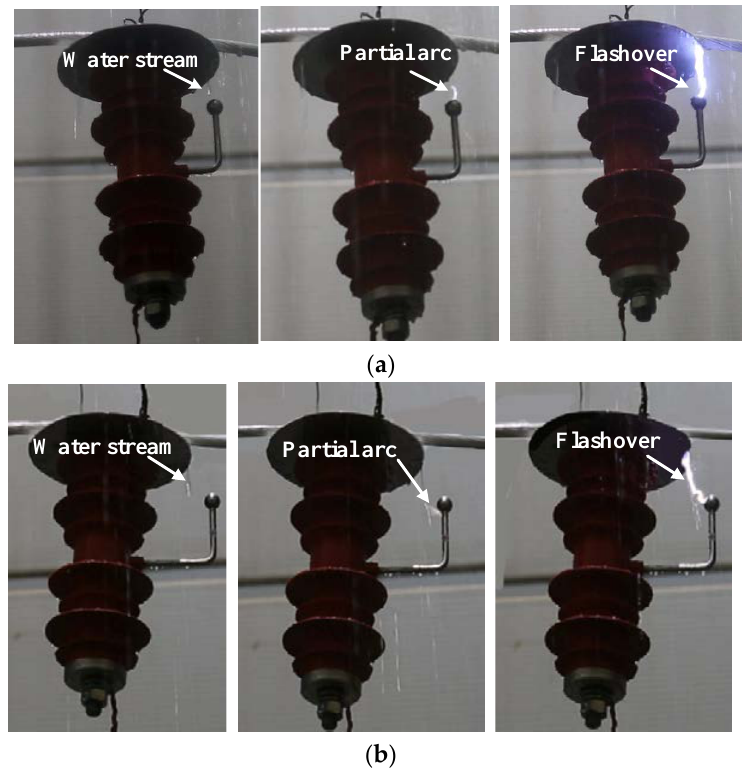
Figure 5. Rain flashover process of the test specimens: ( a ) type 1; ( b ) type 2.